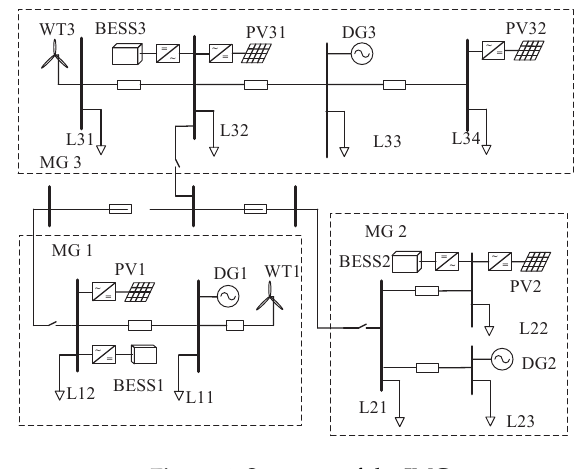
Figure 4. Structure of the IMG. Table 1. Parameters of the distributed energy resources (DERs). WT, wind turbine.